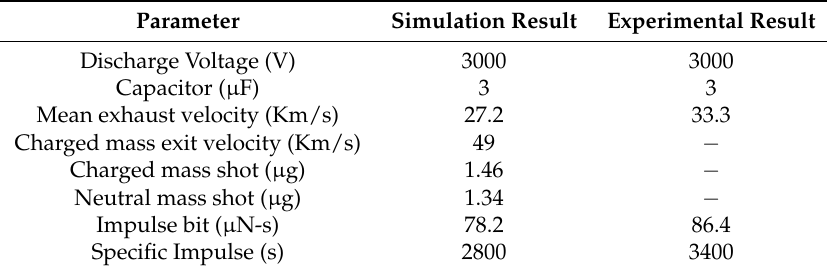
Table 3. Simulation results and Experimental results for